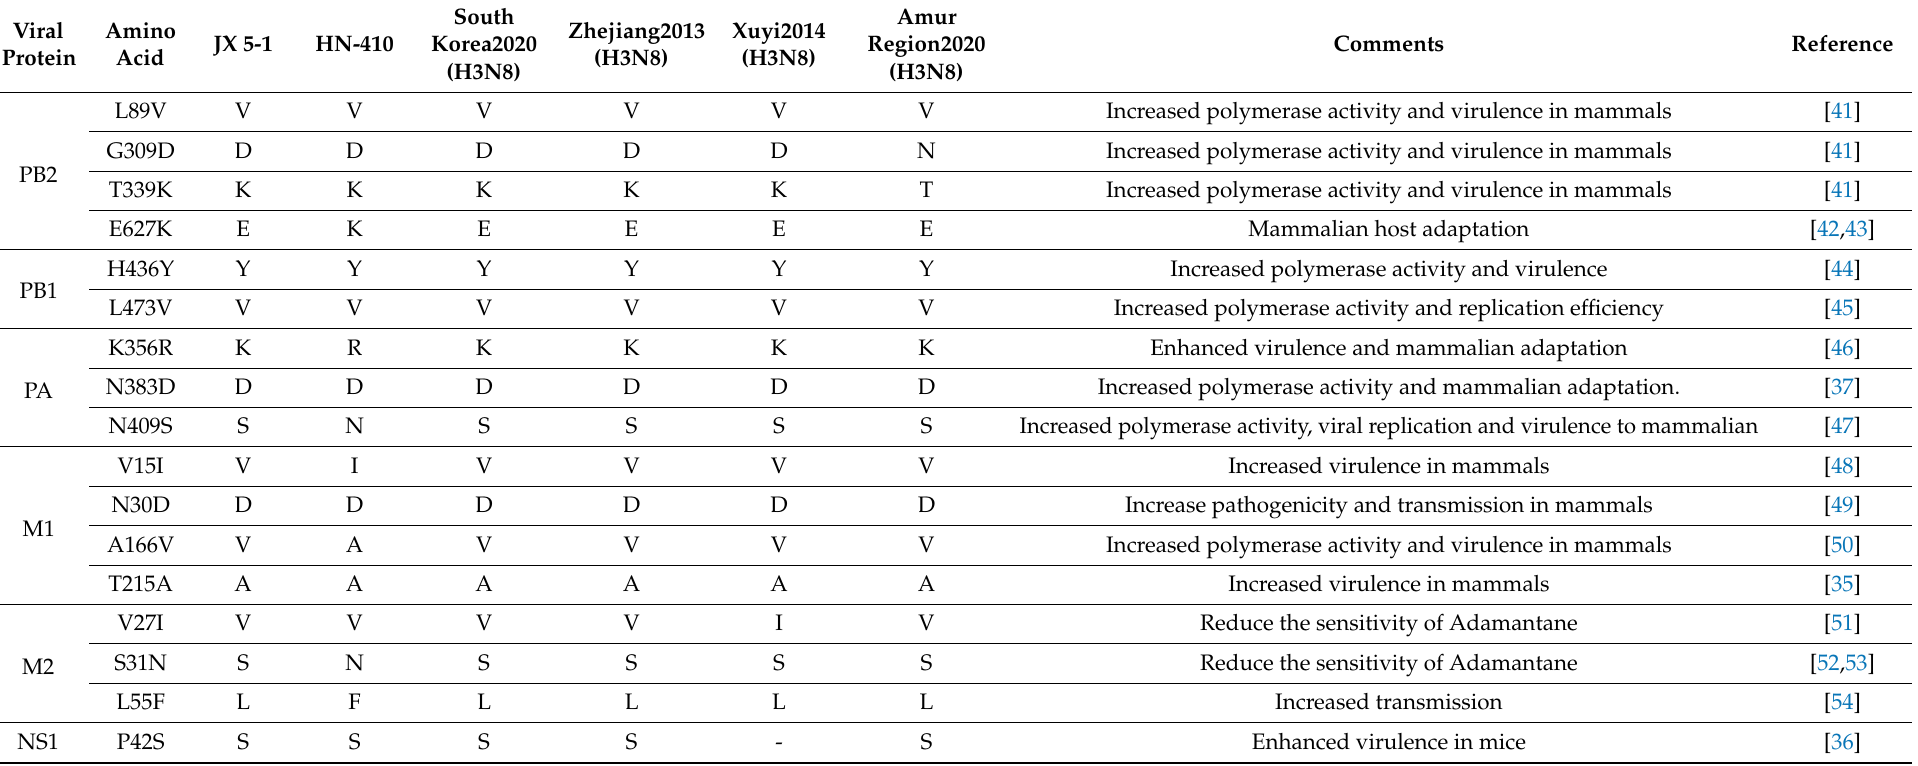
Table 3. Summary of data obtained from the mutational analysis of eight genes from AIVs of multiple avian species with the H3N8 (JX 5-1) isolate. (“-”—no amino acid was